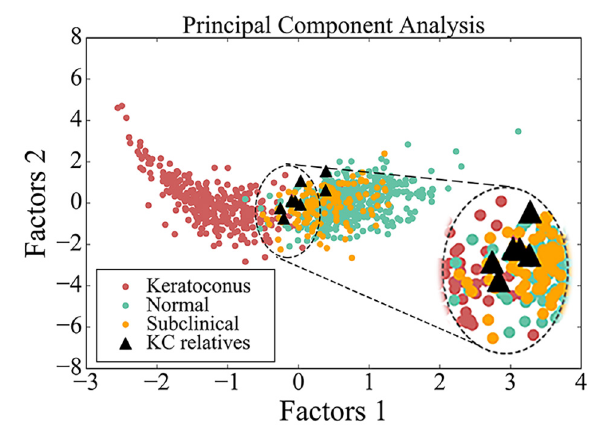
FIGURE 3 | Scatter diagram of data from BAD maps in different groups by principal component analysis. Red circle indicates data from patient with keratoconus, green circle indicates data from control, yellow circle indicates data from subclinical one, and black triangle indicates data from the asymptomatic parent with variant in this study. The image in the upper right corner is a larger image of the dotted line area.